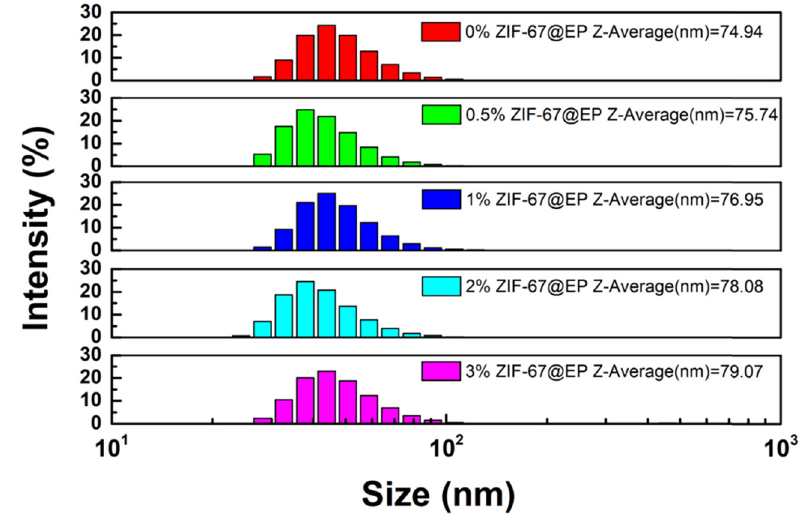
Figure 3: Particle size distribution of composite emulsions.